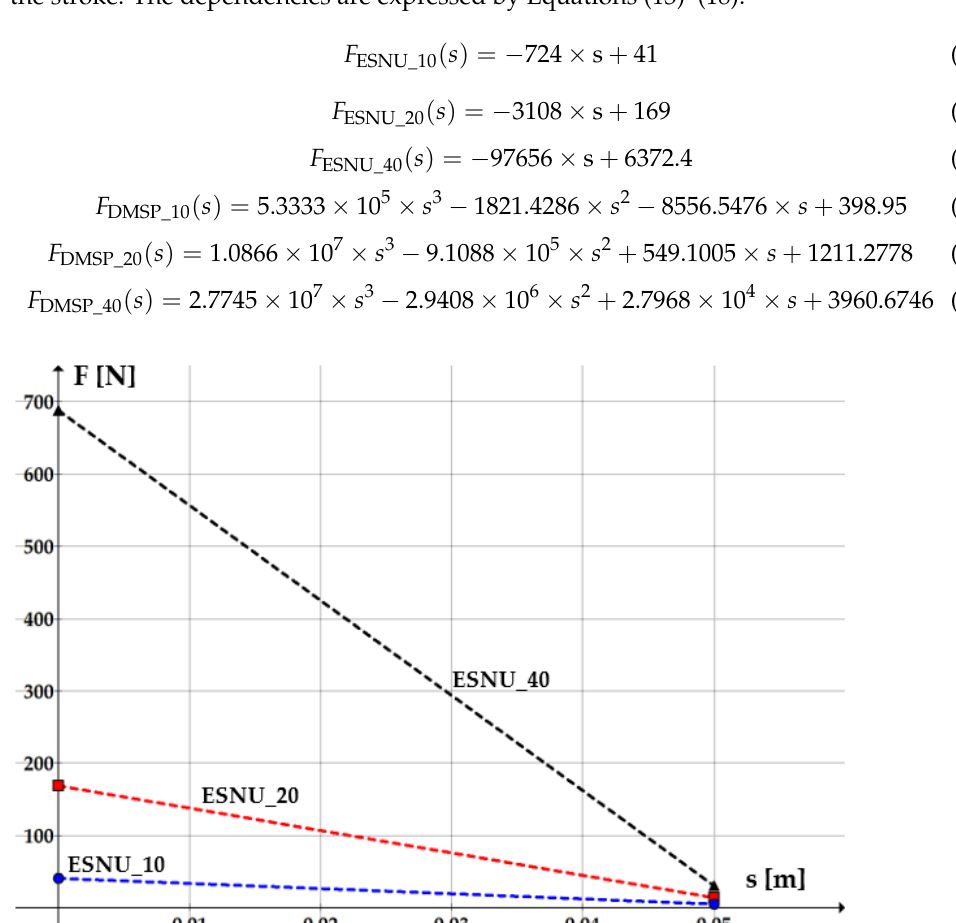
Table 5. Forces developed by the DMSP pneumatic muscles.